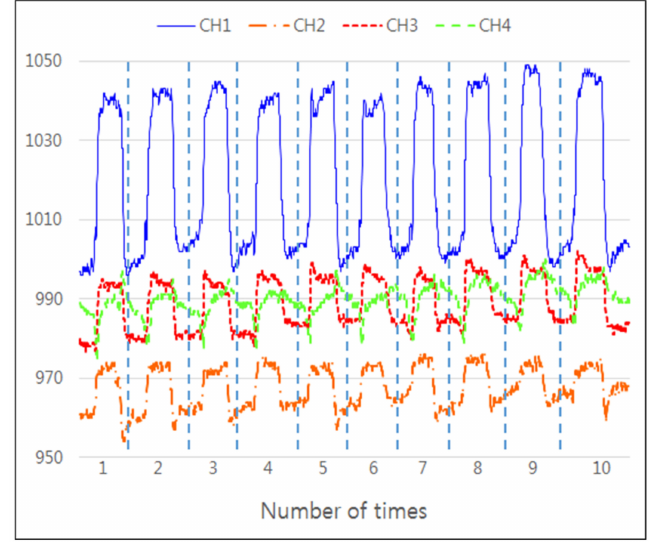
Figure 11. Results of repeatability